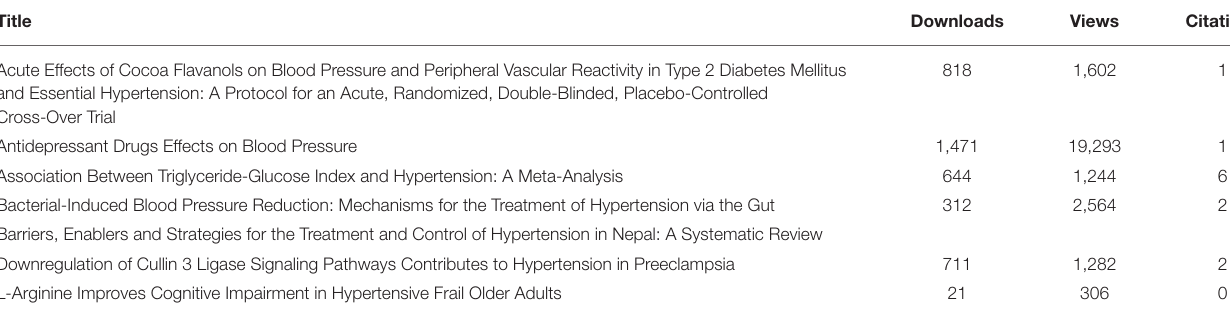
TABLE 1 | Impact of the papers of the Highlights in Hypertension 2021 collection as of 4 May